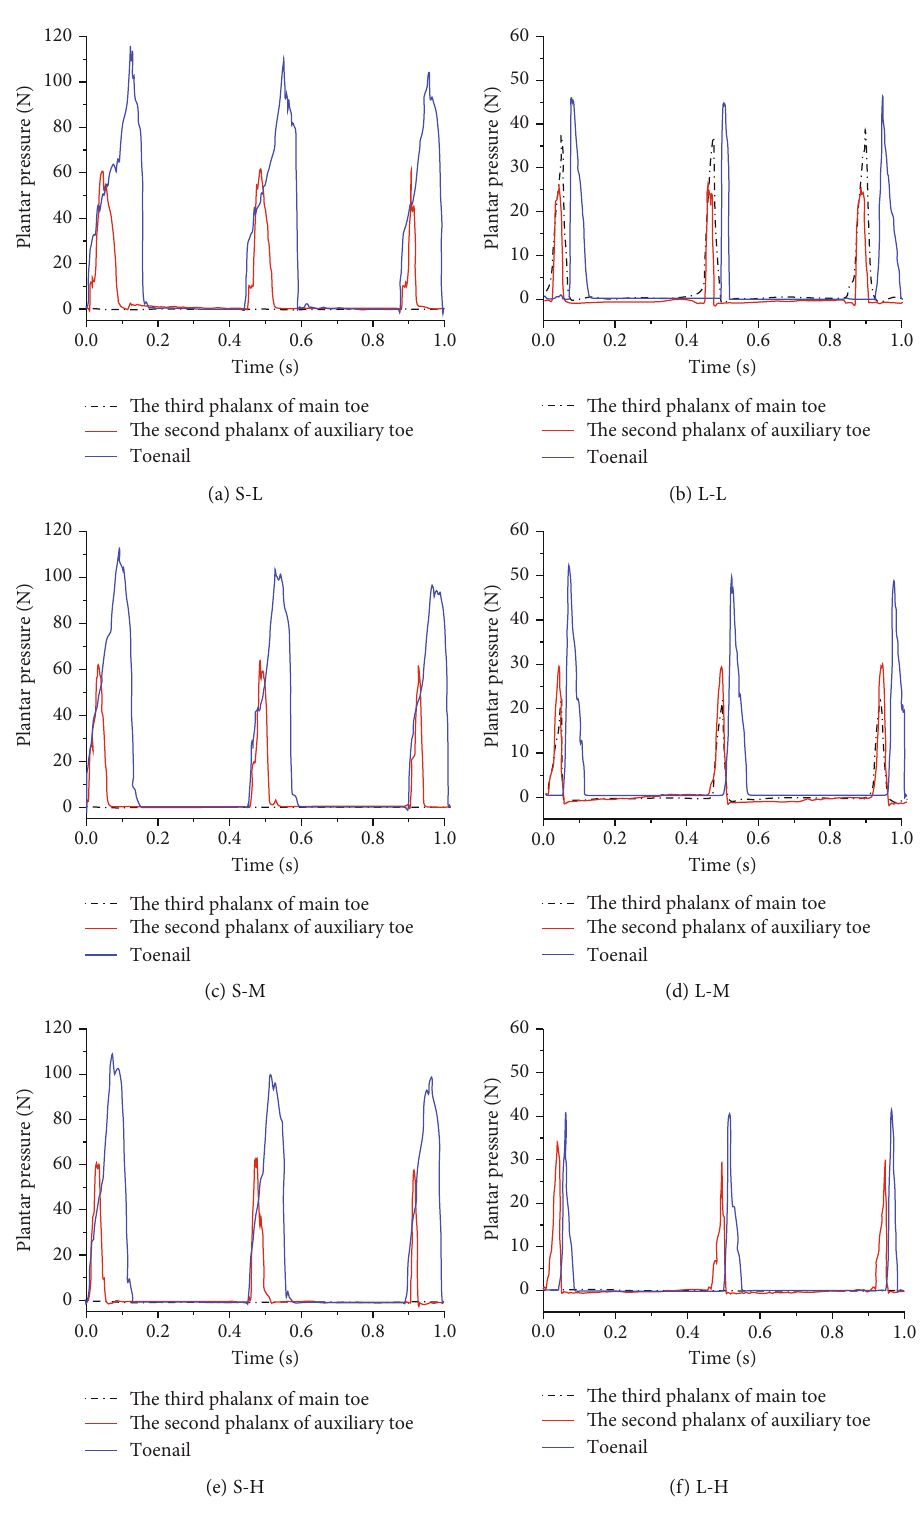
Figure 11: The plantar pressure change curve of the bionic mechanical foot. (a – f) The plantar pressure changes under six working